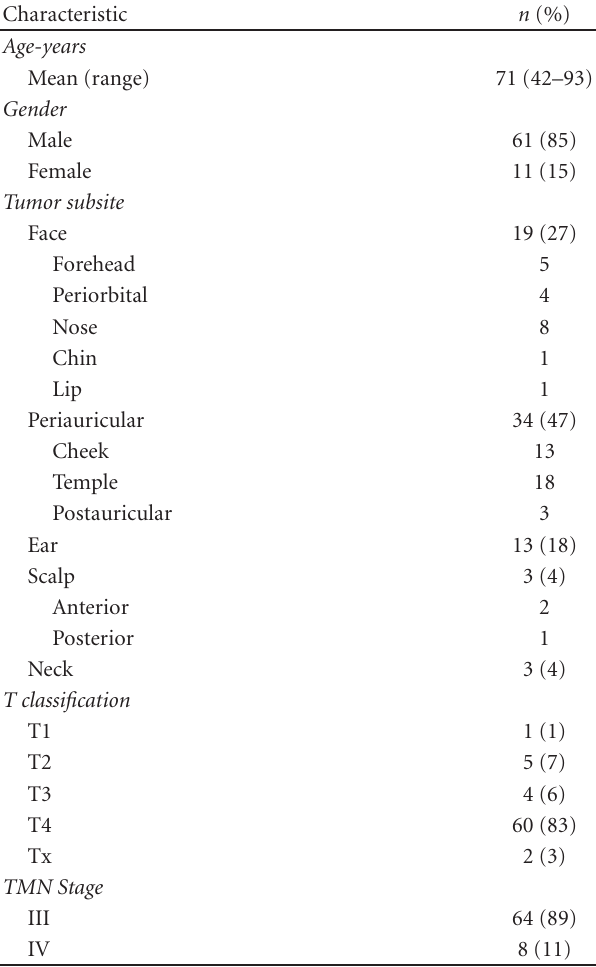
Table 1: Patient